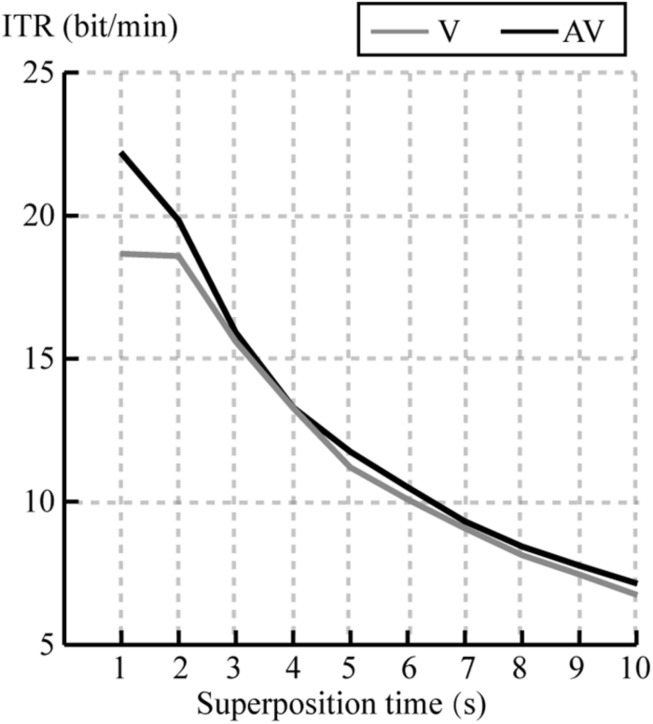
Mean ITR of all subjects at each superposition time for V and AV spelling paradigms.